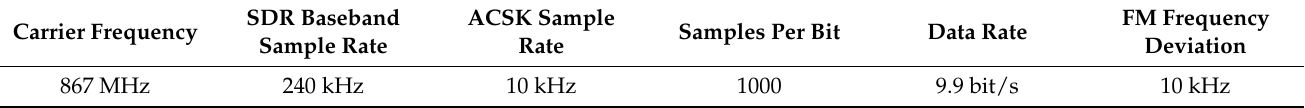
Table 3. Parameters of an FM-ACSK system